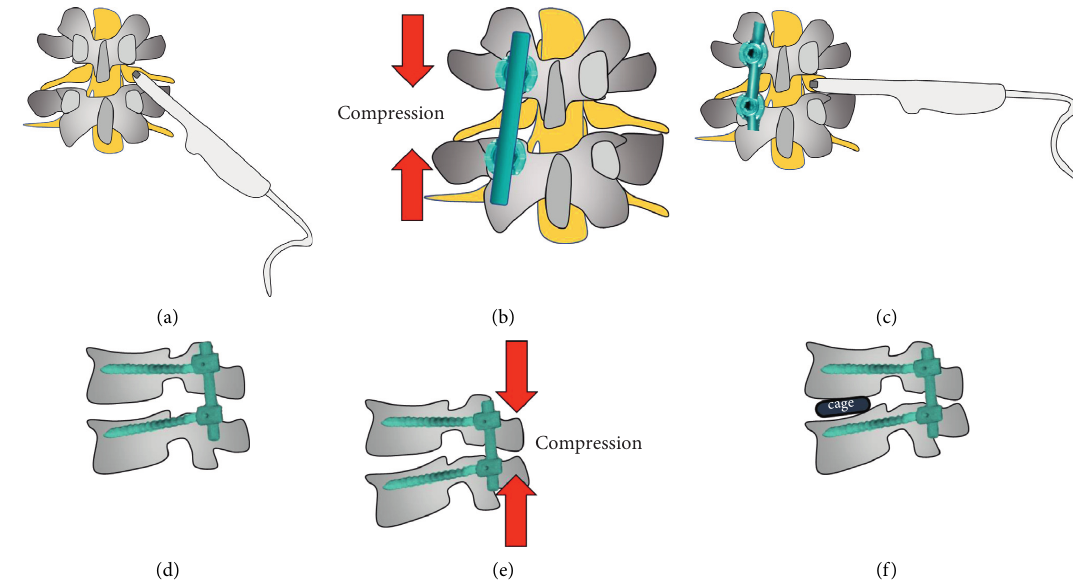
Figure 3: Illustration of the utility of IoUS during operation: (a) measurement of the condition of L5 nerve root before spine shortening; (b) slow spine compression; (c) measurement of the condition of L5 nerve root after spine shortening; (d) sagittal view of the affected segment before compression; (e) sagittal view of slow spine compression; and (f) sagittal view of cage